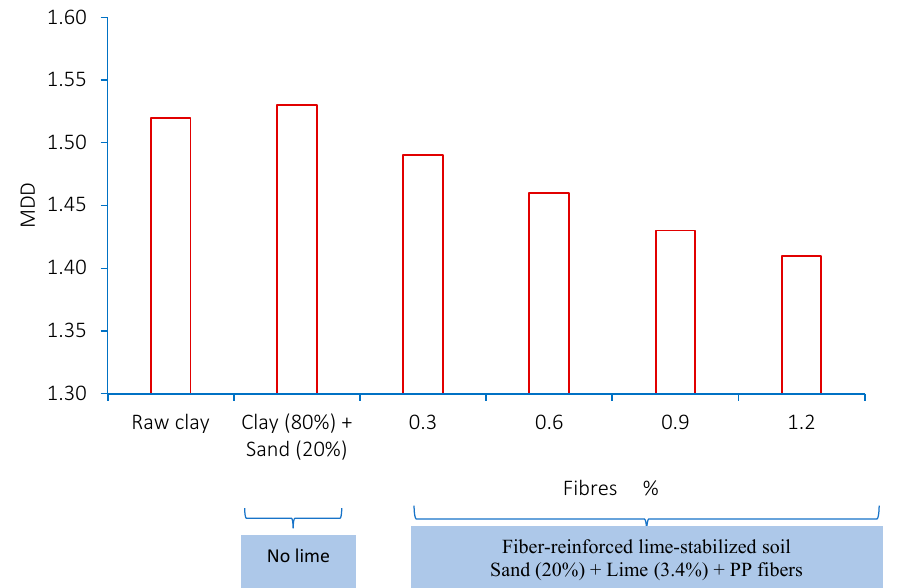
Figure 7. Maximum dry density (MDD) for different mixes.